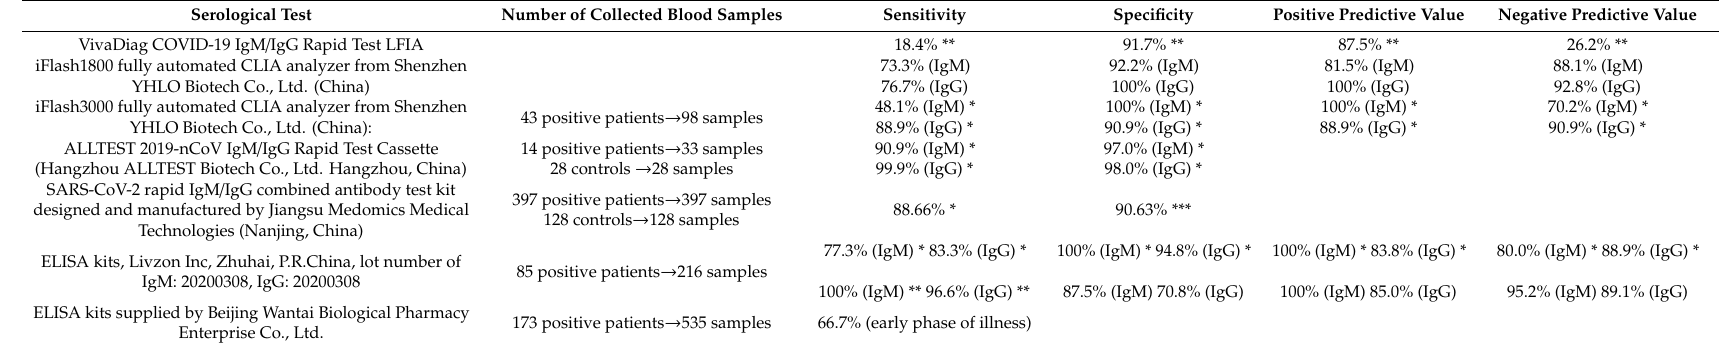
Table 6. Sensitivity, specificity, positive predictive values and negative predictive values of serum IgM and IgG antibodies to diagnose